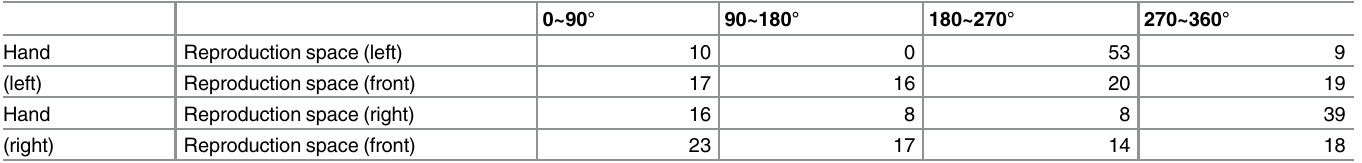
Table 2. The frequency of mean trials reproduced in the four